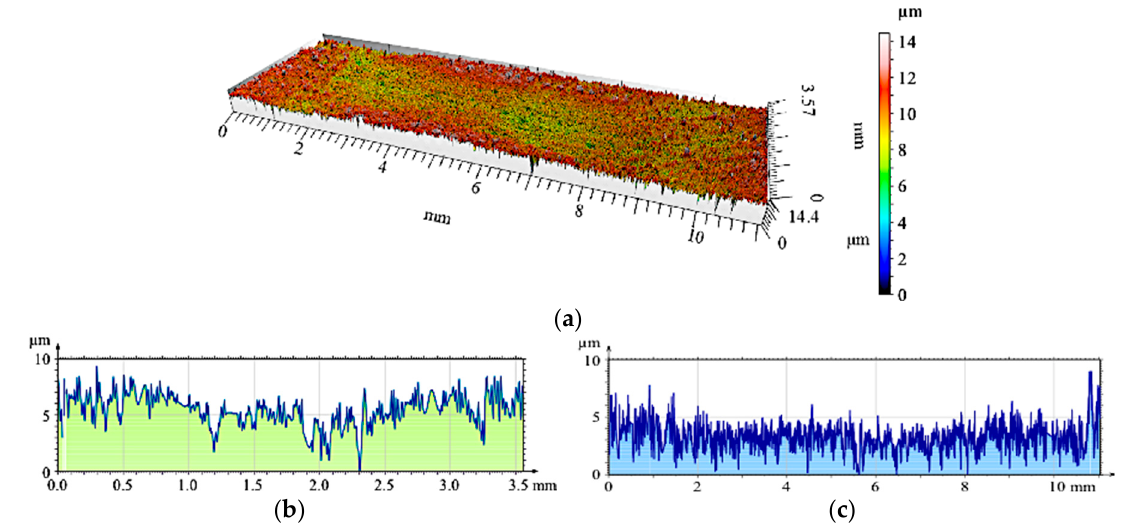
Figure 20. The surface geometry of the hybrid composite layer (C3S7) after working with a cast iron pin: ( a ) View of the wear track; ( b ) Roughness distribution across the friction direction; ( c ) Roughness distribution along the friction direction.